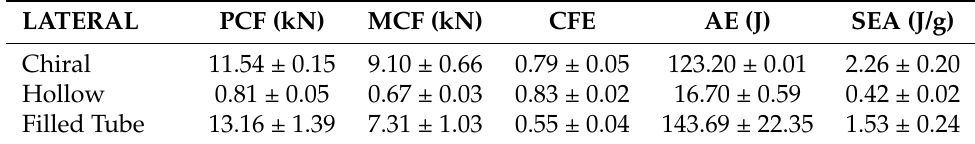
Table 9. Average crush properties of the chiral structure, hollow tube and filled tube under lateral